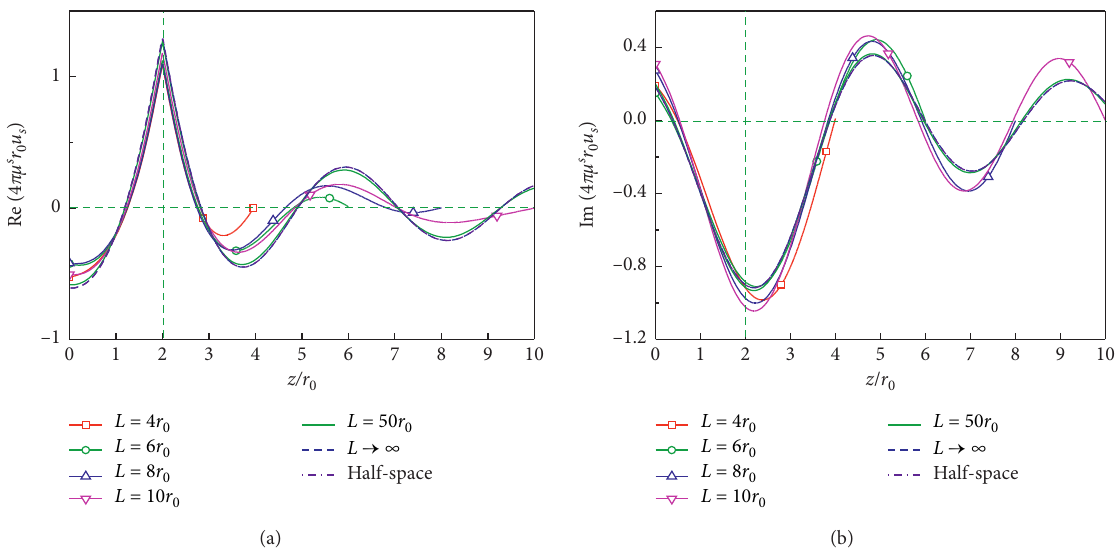
Figure 10: Lateral displacement u part of lateral